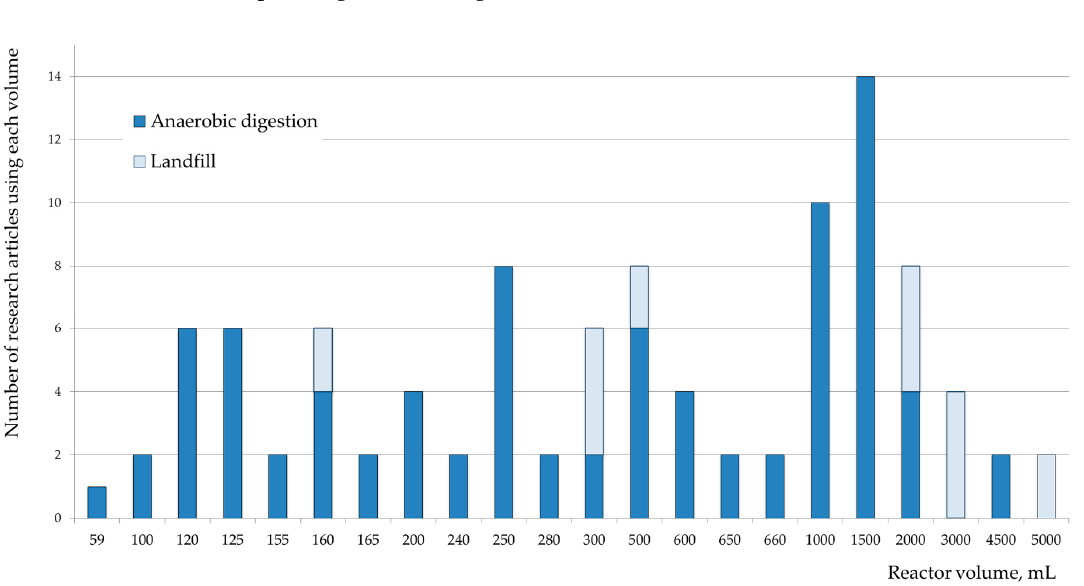
Figure 2. Volume of bioreactors used in the assessment of plastics.